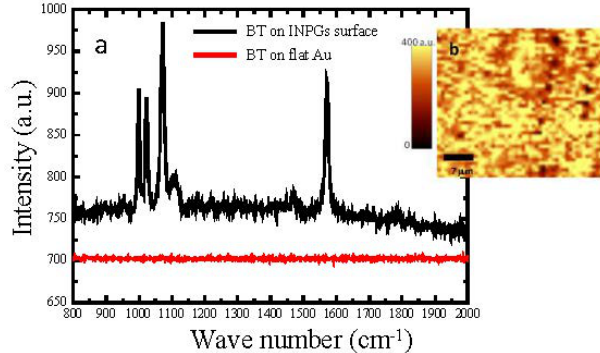
Figure 10: SERS measurement results. (a) Monolayer BT Raman spectra measured from the Au coated INPG surface (black) and a flat Au surface (red); (b) 1600 µ m 2 Raman mapping on the Au coated INPG surface. Raman shift spectra at 990 cm −1 was used to make the Raman map. Adapted from Ref.